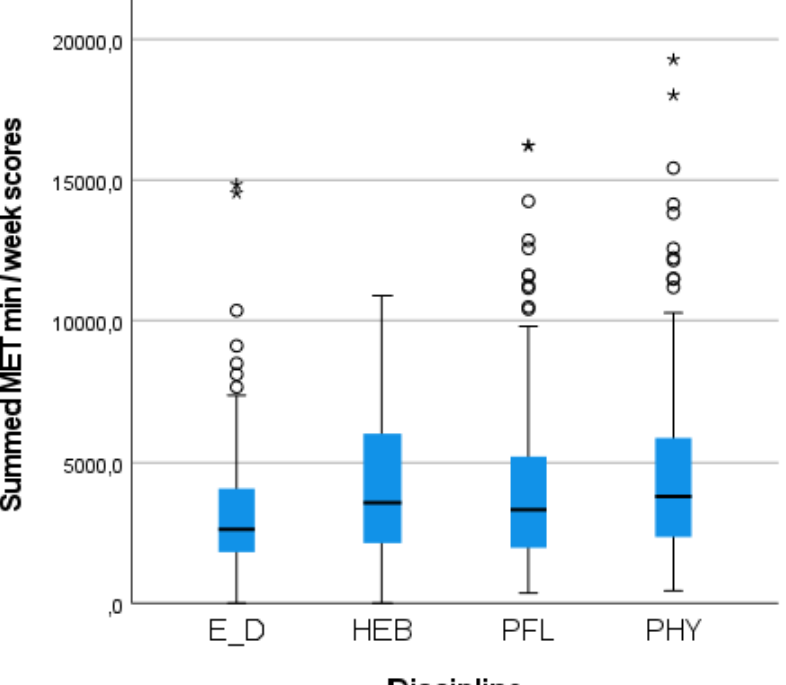
Figure 1. Box plots of the physical activity scores (summed metabolic equivalent [MET] min/week scores) per health profession division of a Swiss university of applied sciences during the spring 2020 COVID-19 lockdown. Whiskers indicate 1.5 × IQR unless truncated at the lowest score. Asterisks and circles represent values outside this range. E_D: nutrition and dietetics; HEB: midwifery; PFL: nursing; PHY: